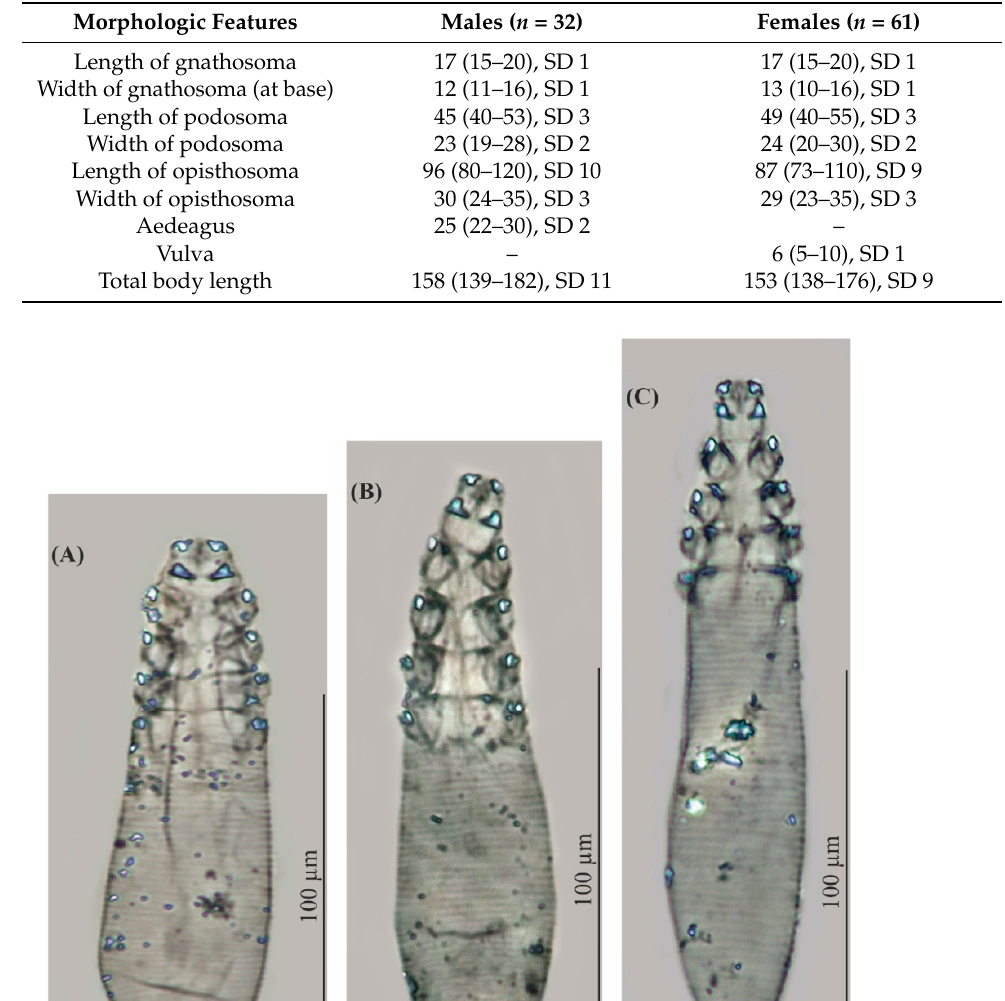
Table 1. Measurements of morphological features (in micrometers) for adults of Demodex crocidurae sp. nov.